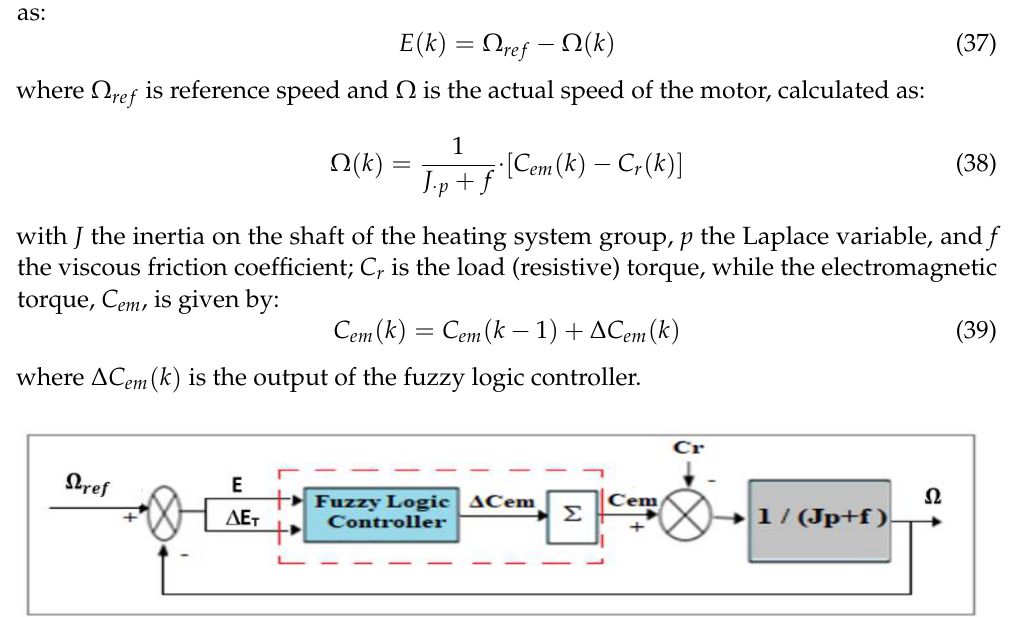
Figure 10. Scheme of the PI controller Optimized by Fuzzy Logic (PIOFL).